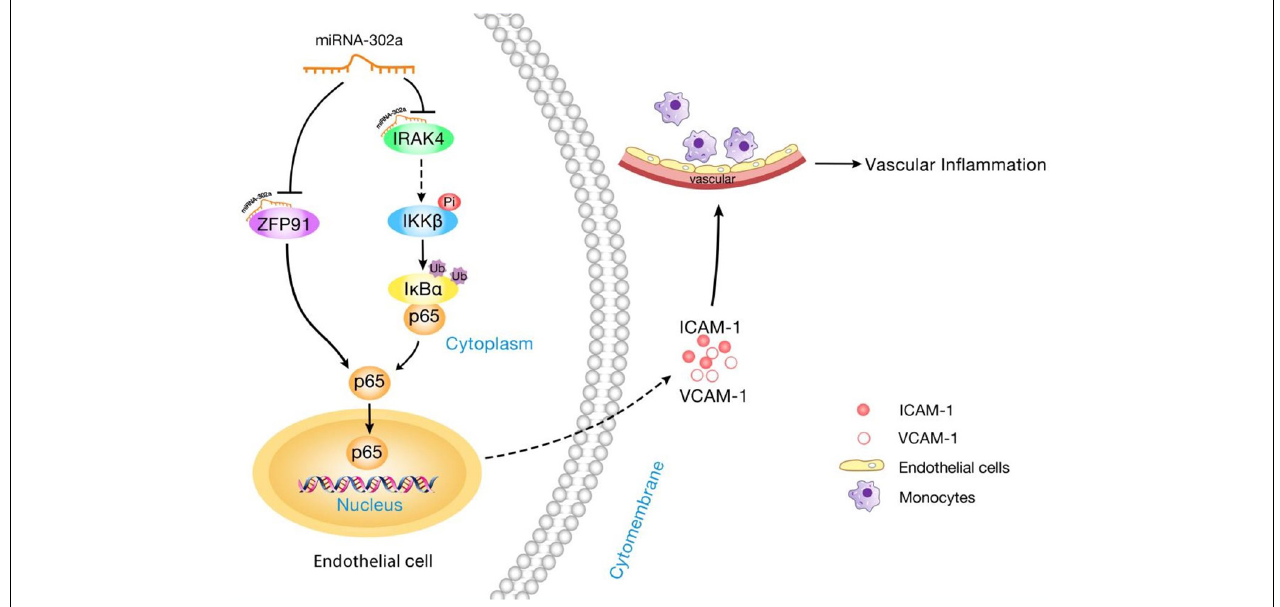
FIGURE 8 | Schematic diagram of the mechanism for miR-302a in regulating endothelial inflammation. MiR-302a limits vascular inflammation by suppressing NF- κ B pathway by targeting IRAK4 and